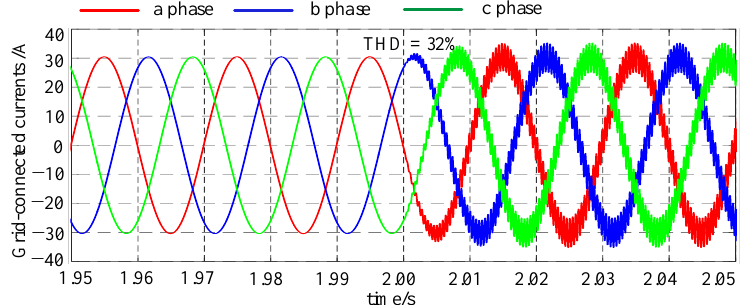
Figure 17. Current waveform of three VSGs with 2.25 kHz harmonic voltage injected.